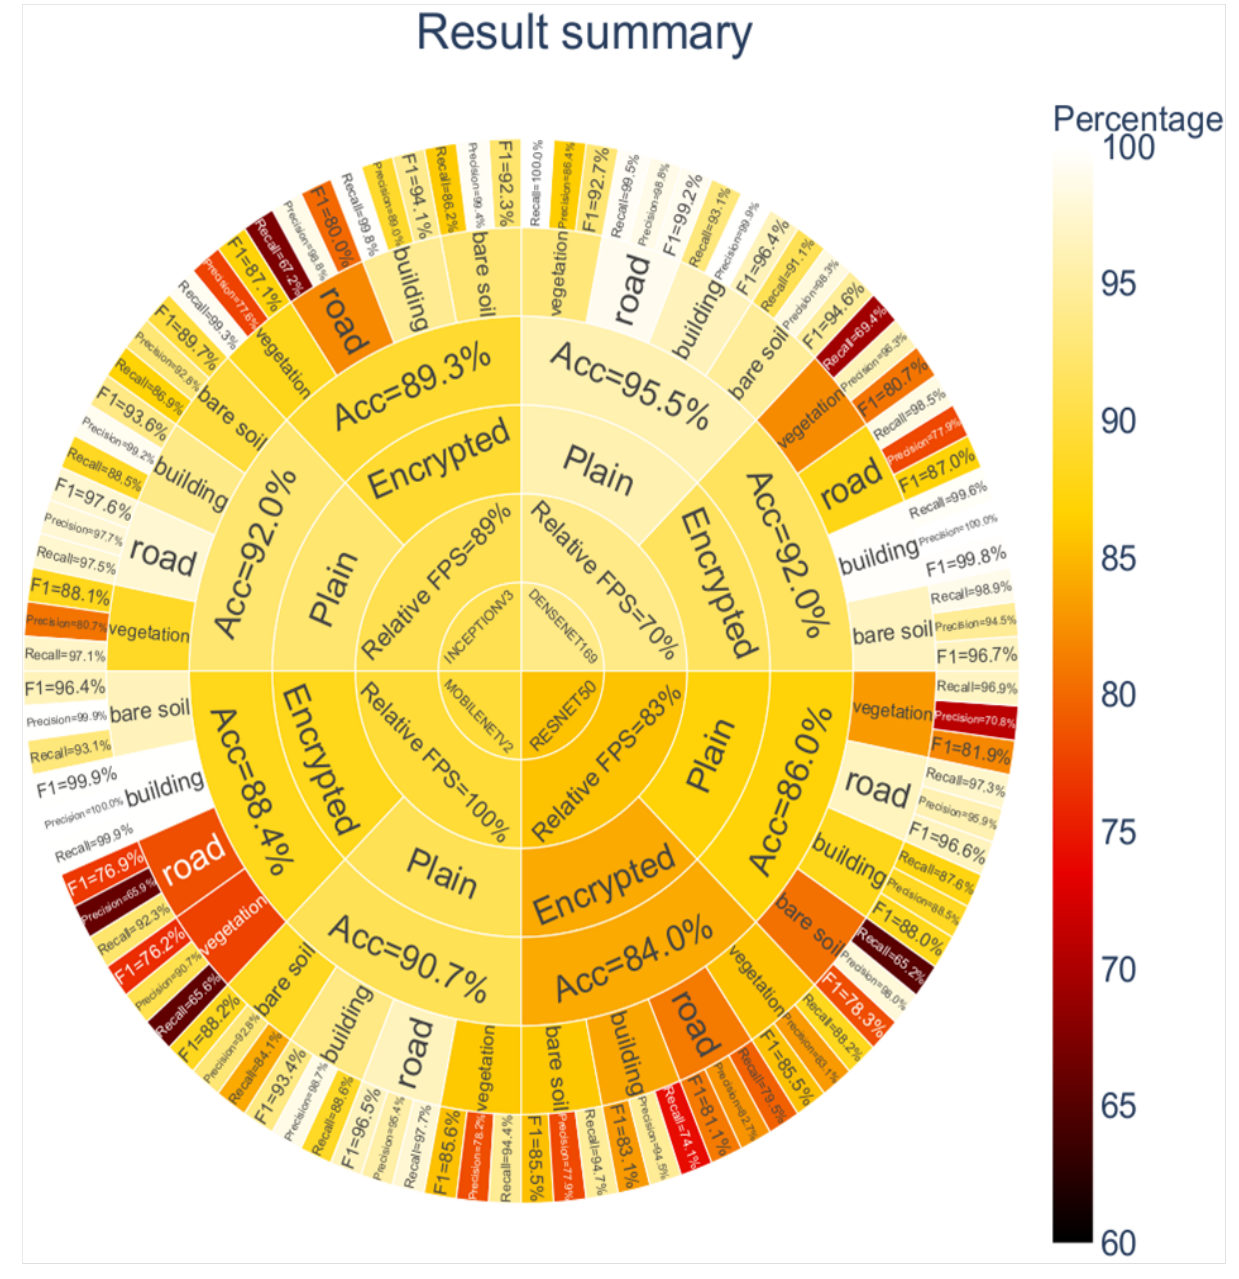
Figure 11. Summary of the results of the four CNN models in a sunburst chart. The relative FPS corresponds to the number of processed frames per second divided by the maximum obtained value (632 for MobileNetV2). The color of inner sectors (representing algorithms) corresponds to the average colors of outer sectors belonging to them: the lighter the color, the better the results